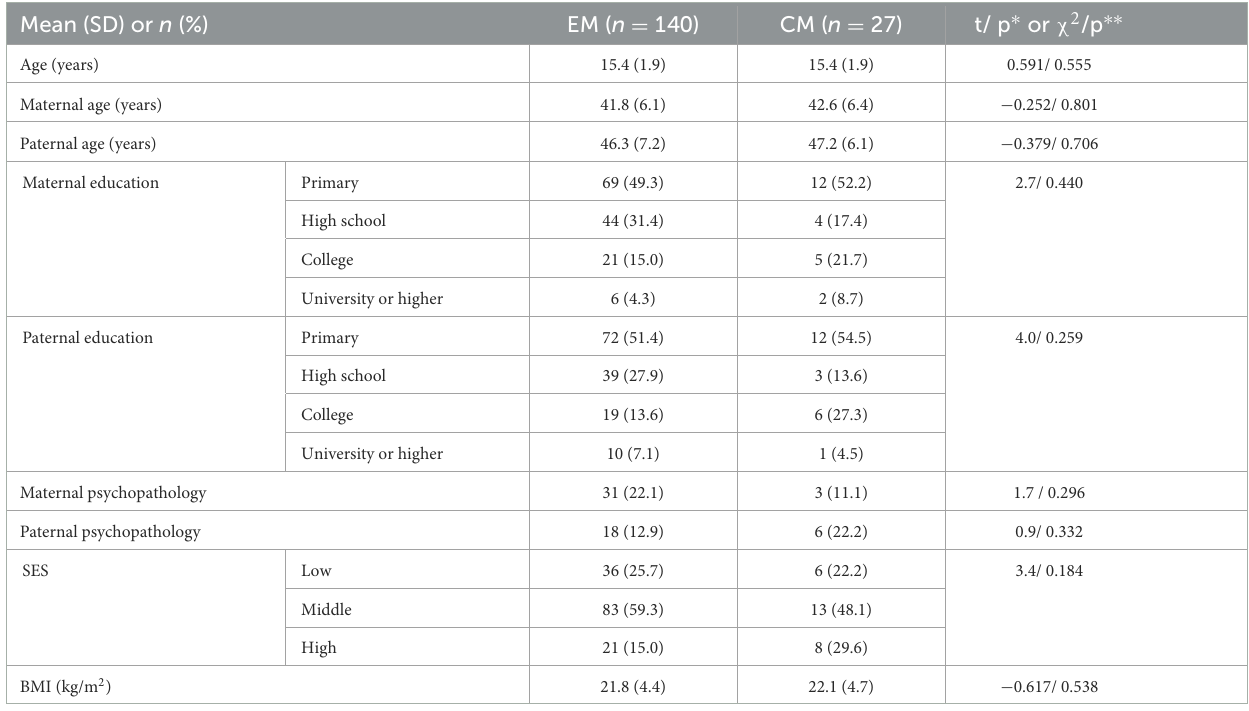
TABLE 1 Sociodemographic features of the respondents and their families according to migraine type. Mean (SD) or n (%)